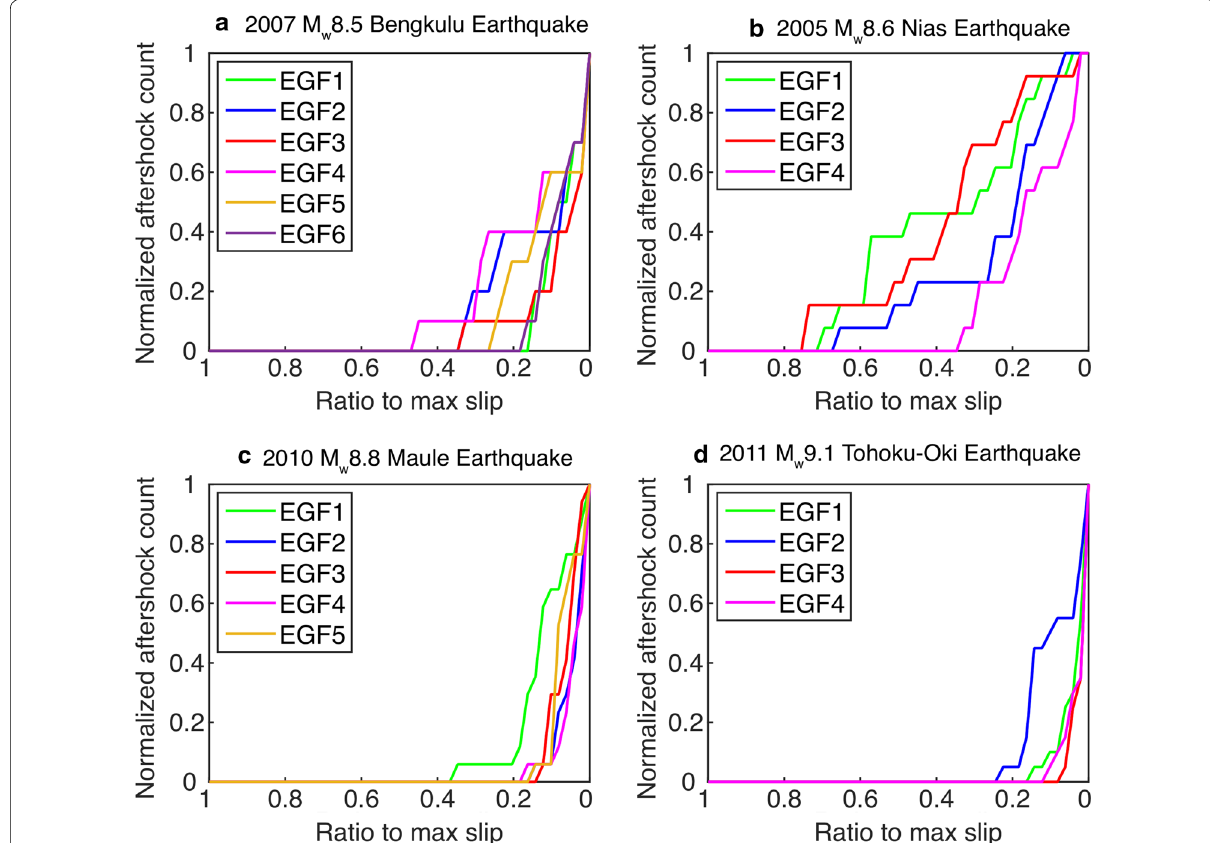
Fig. 9 Quantitative comparison between the aftershock locations and normalized mainshock slip for the a Bengkulu, b Nias, c Maule, and d Tohoku‑Oki earthquakes. The number of aftershocks, which is normalized by the total aftershock count, that occurs at the location that experienced mainshock slip within various thresholds (vertical axes), is plotted against different thresholds of slip during the mainshock, which are the amount of slip at the site of the aftershock normalized by the maximum mainshock slip (horizontal